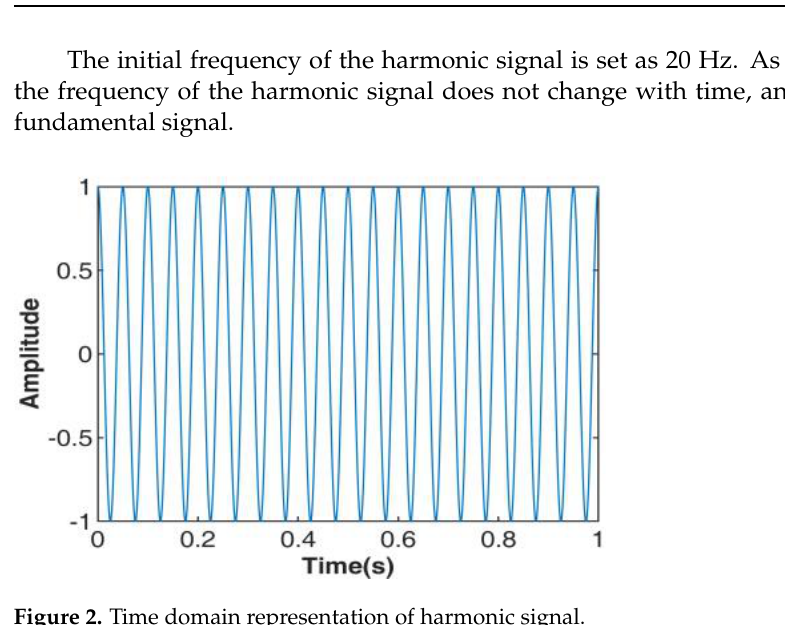
( c ) Figure 3. Time-frequency analysis of harmonic signal ST. ( a ) ST three-dimensional representation; ( b ) ST time-frequency representation; ( c ) ST frequency spectrum.